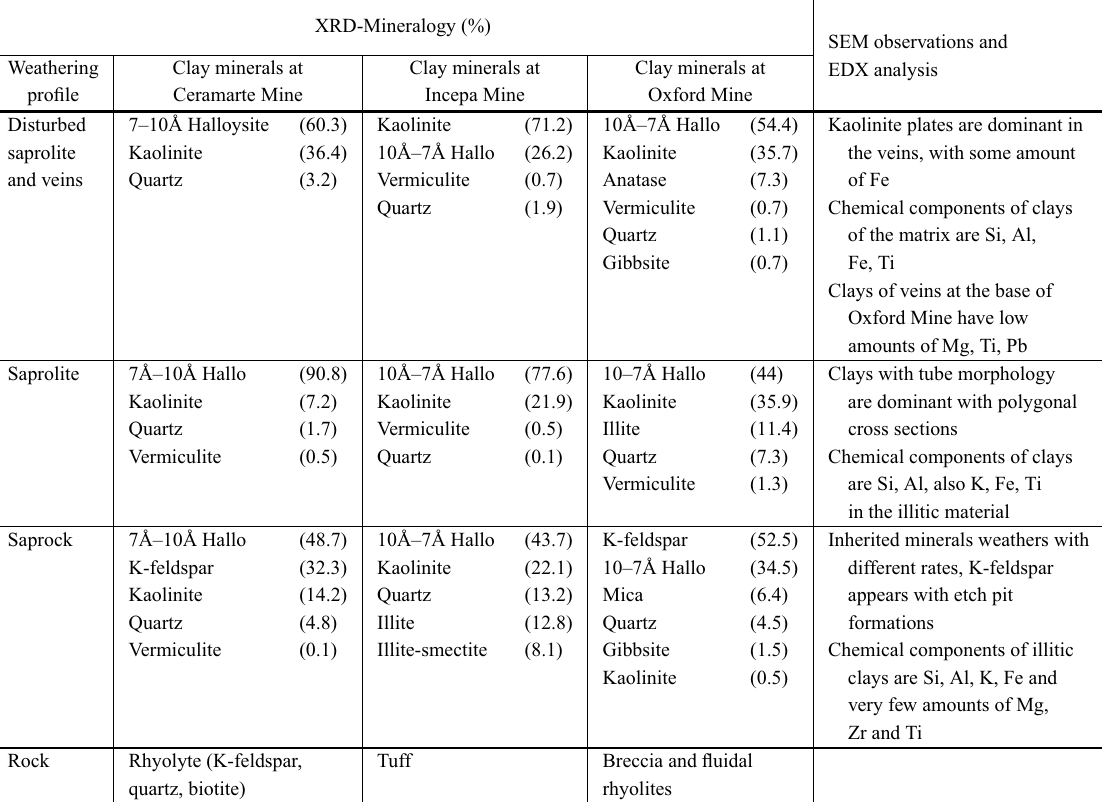
Distribution of mineralogy and elemental composition (EDS) of the clay particles observed with SEM, pursuing macroscopical differentiation in the wall of the